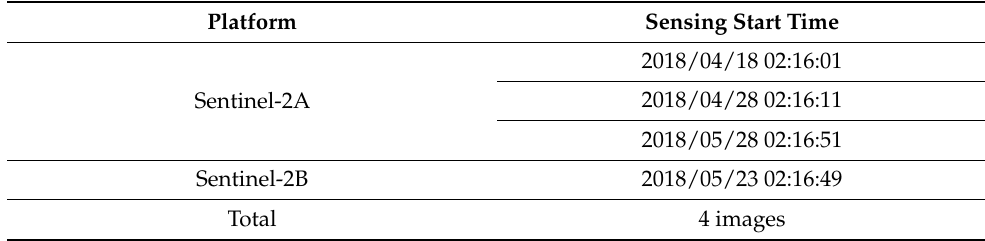
Table 1. Sentinel-2 sensing start times used for the